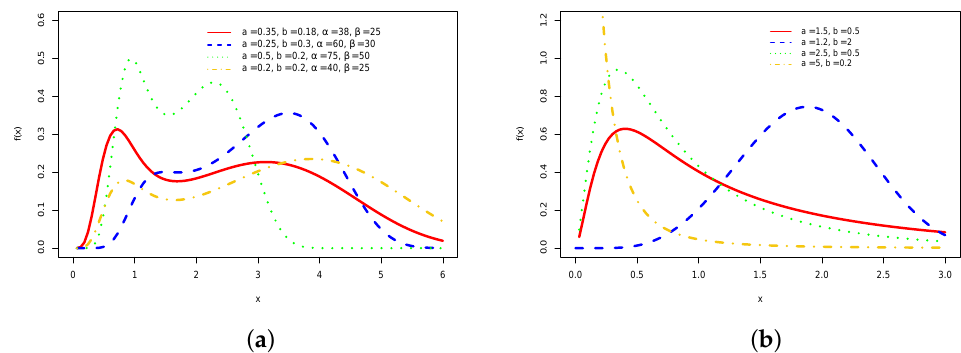
Figure 1. Density functions: ( a ) WBP( a , b , α , β ) and ( b ) WBP( a , b ,5,2.5).